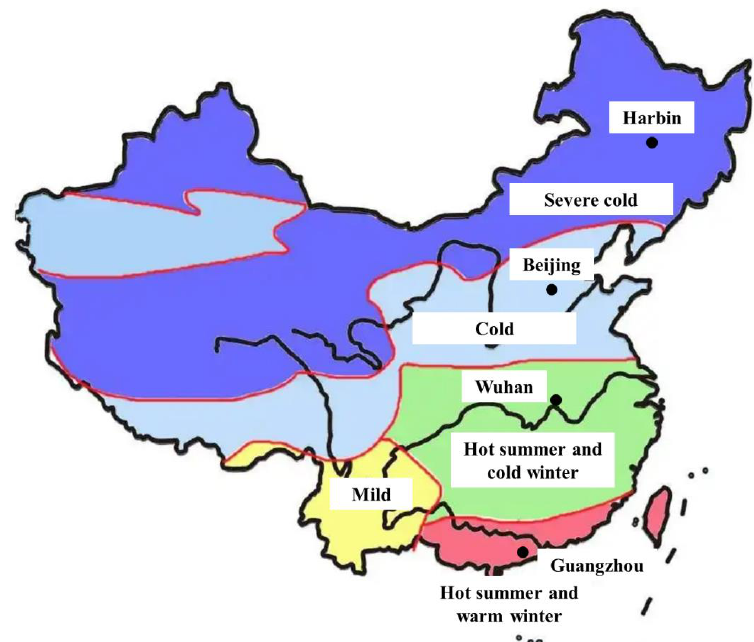
Figure 1. Layout of five climatic zones in China and the location of target